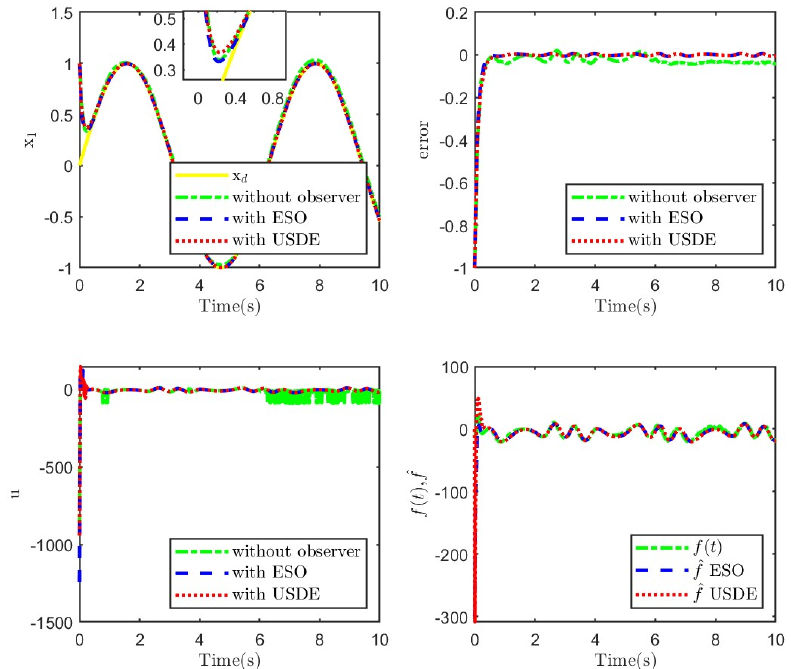
Figure 9. Tracking results of the system with mismatched uncertainty under the step signal.